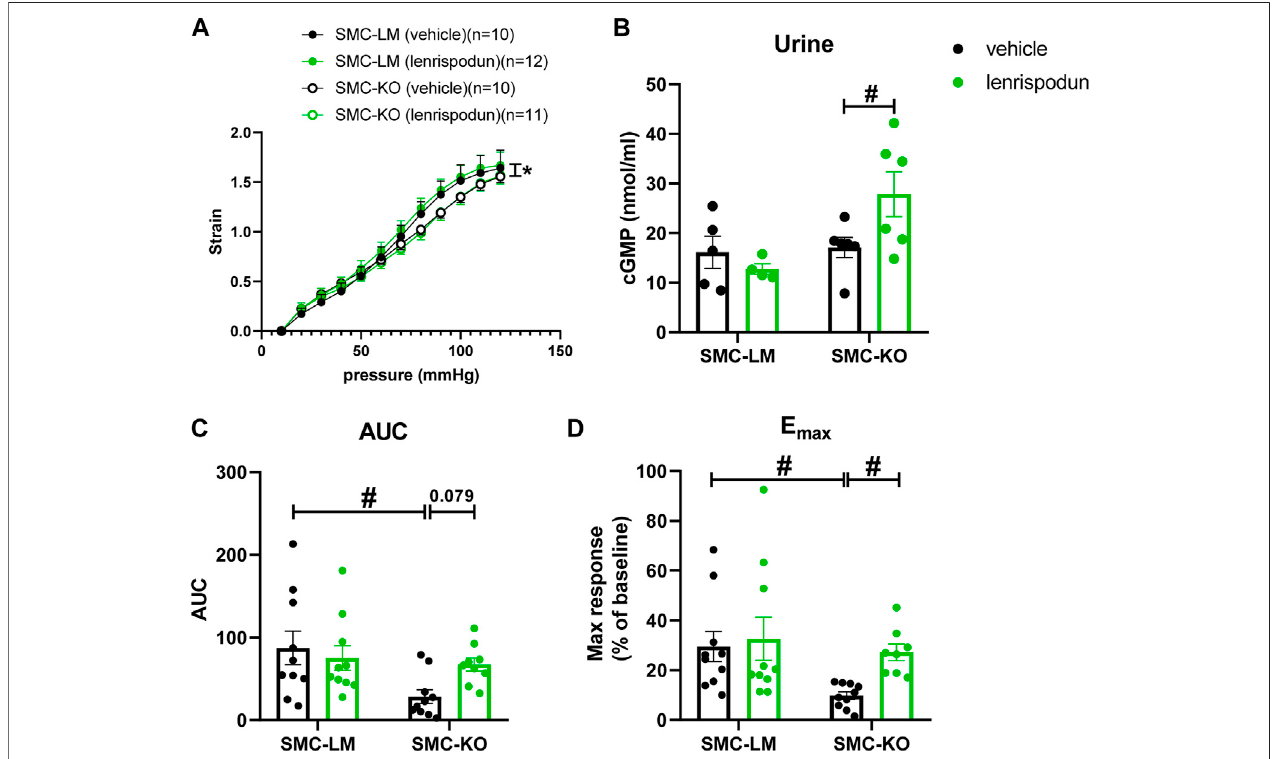
FIGURE 3 | The ex vivo stiffness (A) in carotid artery segments of SMC-KO mice versus their SMC-LM. Lenrispodun-treated samples are shown in green. Compliancewasmeasuredbypressuremyographytechniqueandplottedasintraluminalpressurevs.strain.ThecGMPcontent (B) intheurineofSMC-KOmiceversus their SMC-LM, lenrispodun-treated samples are shown in green. In vivo cutaneous microvascular reactive hyperemia in SMC-KO mice versus their SMC-LM measured with Laser Doppler, expressed as (C) area under the curve (AUC) and (D) maximum response (Emax); *, p < 0.05, GLM for repeated measures; #, p < 0.05, two- way ANOVA followed by Bonferroni ’ s post hoc